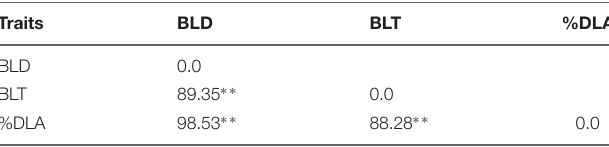
TABLE 6 | Correlation coefficient between BLD, BLT, and %DLA for pathotype P7.2 in BC 2 F 2 population. Traits